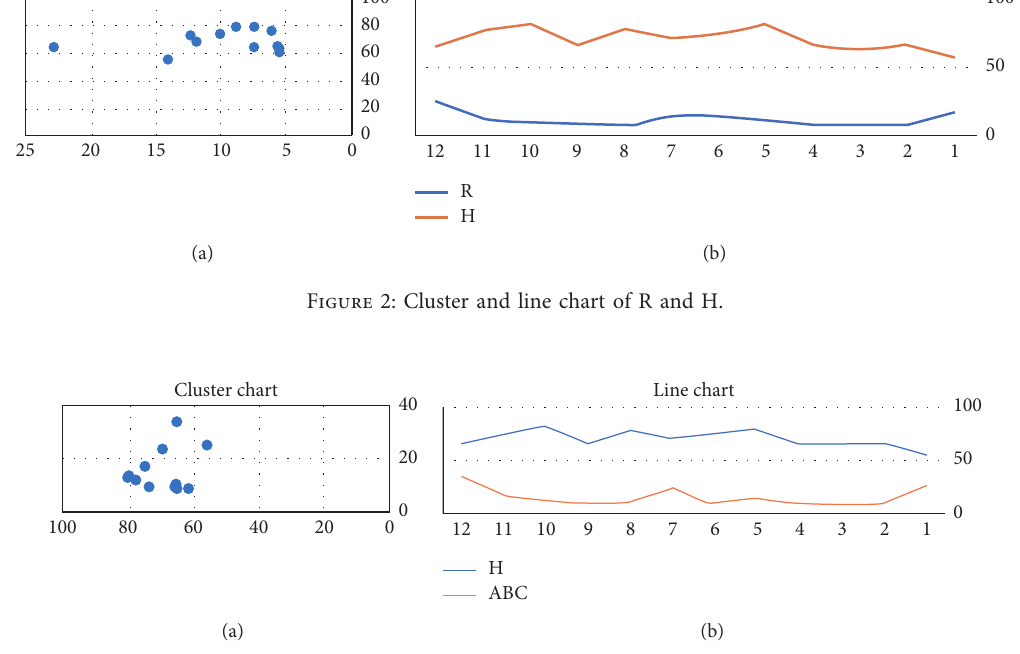
Figure 3: Cluster and line chart of ABC and